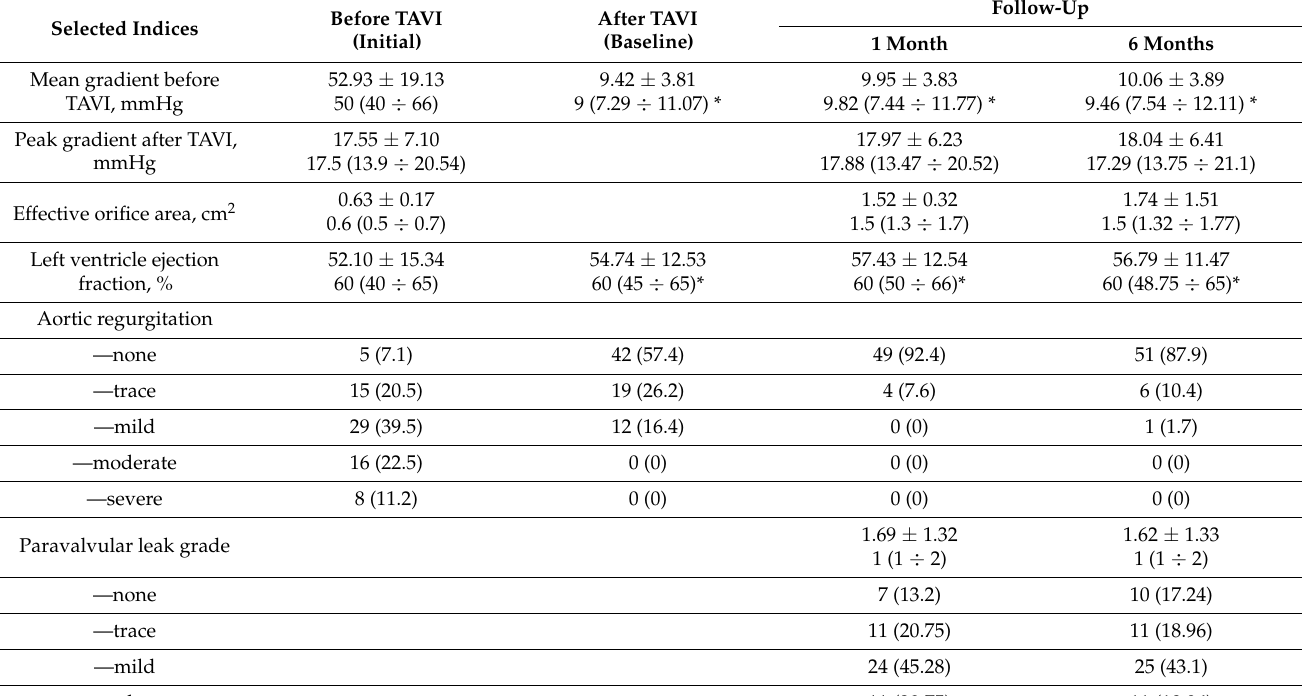
Table 2. Initial and follow-up echocardiographic